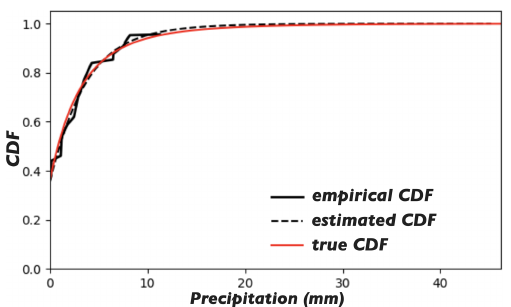
Figure 6. The solid and dashed black lines show the empirical and estimated rainfall CDFs for the specific case shown in Fig. 5b. The red line shows the true rainfall CDF used in the generation of the true